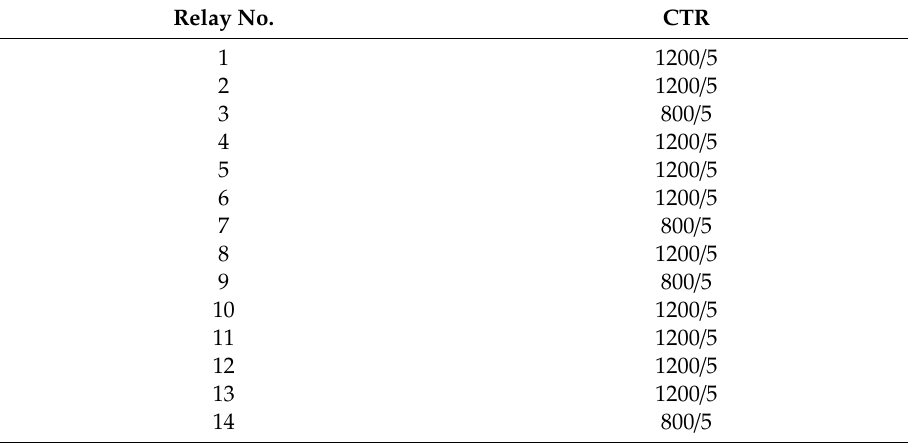
Figure 5. The IEEE eight-bus system. Table 5. Current transformer ratio of the IEEE eight-bus system.